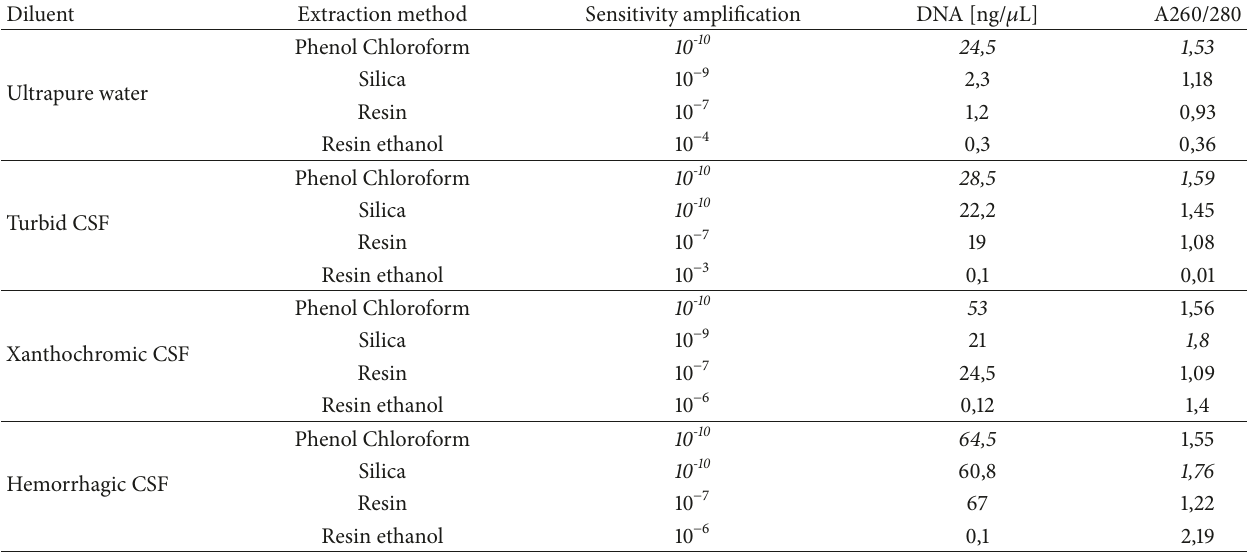
Table 3: Nanovue results form four extraction protocols.